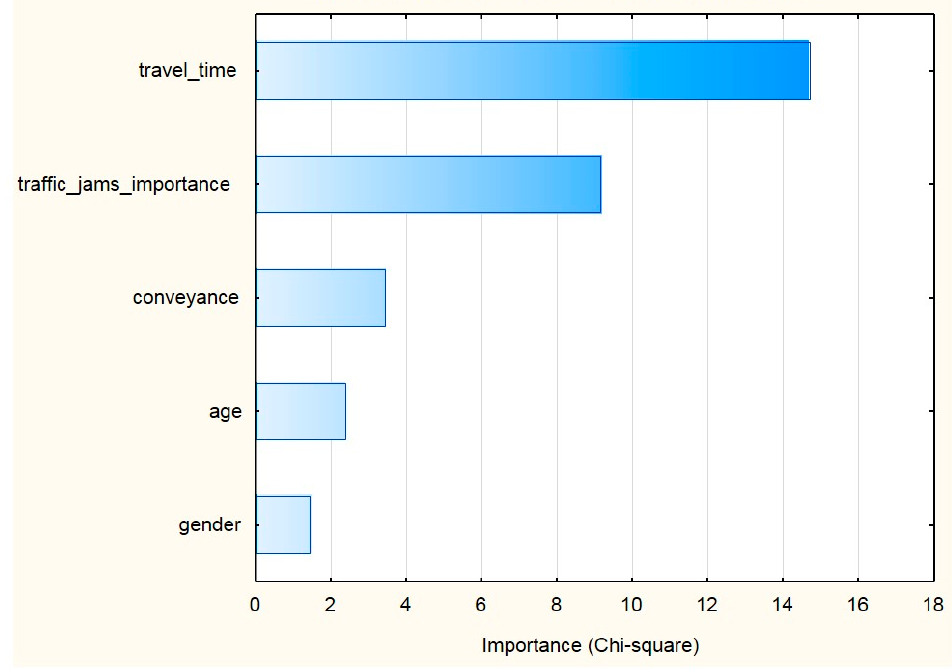
Figure 3. The ranking of predictors’ importance explaining the users’ inclination towards carpooling with gamification.